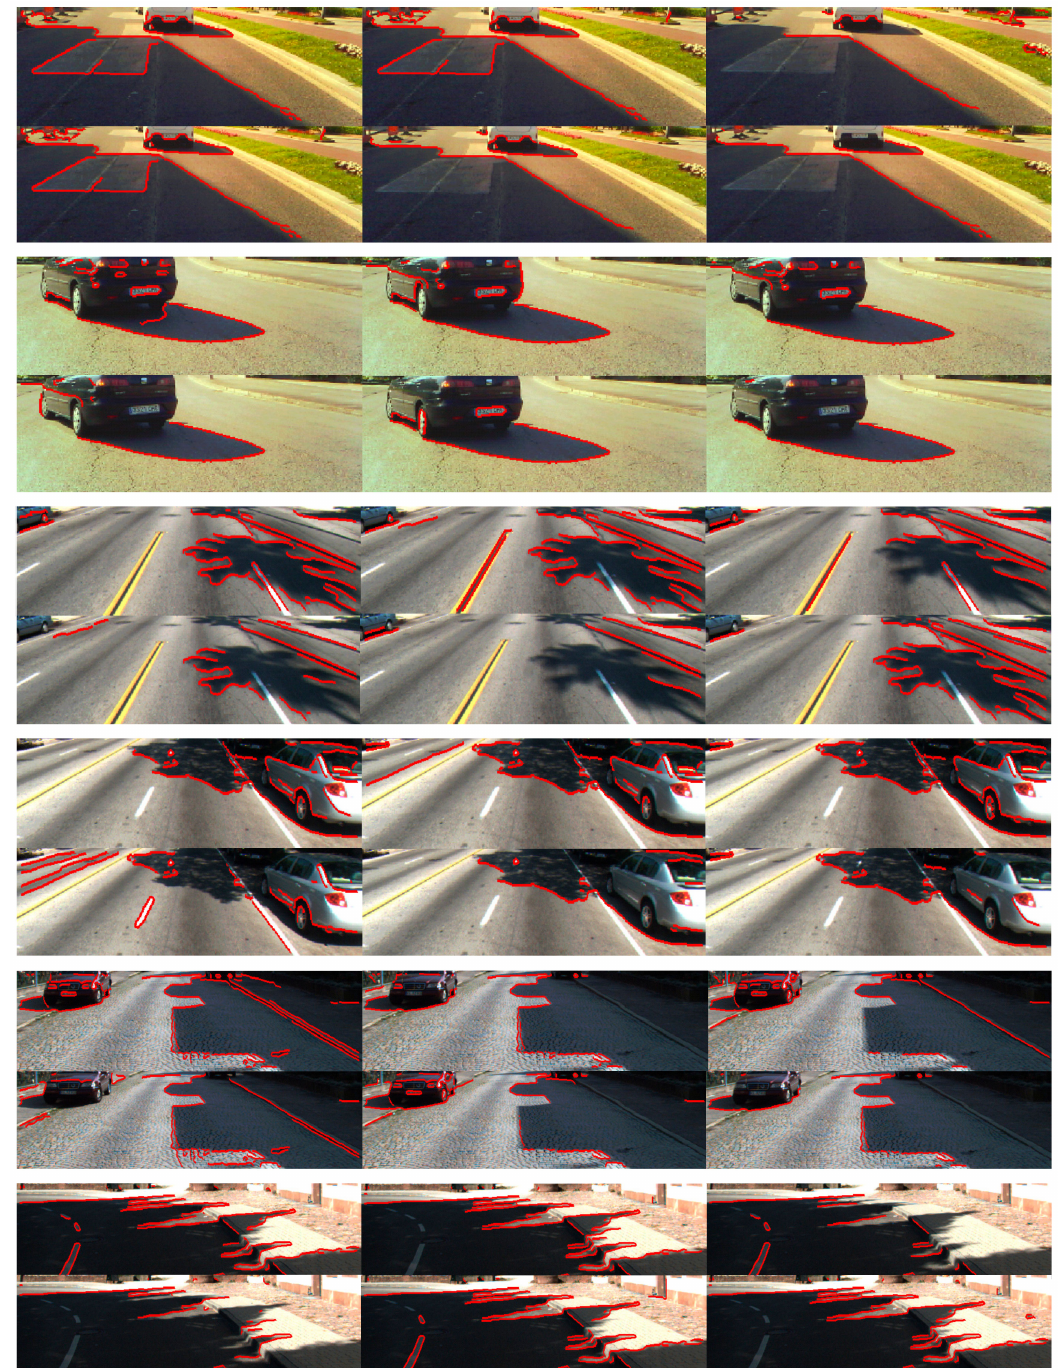
Figure 22. Shadow edge detection results obtained using the five methods. ( First and second scenes ) ROI of images of our dataset; ( third and fourth scenes ) ROI of images of the Caltech Lane dataset; ( fifth and sixth scenes ) ROI of images of the Kitti Road dataset. For each scene: Top-left results of Method 1; top-center results of Method 2; top-right results of Method 3; bottom-left results of Method 4; bottom-center results of Method 5; bottom-right results of our